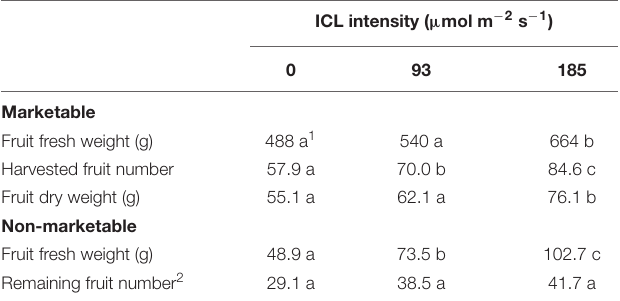
TABLE 6 | Blackberry yield per cane during the autumn production cycle (harvest from 3 October till 12 December as affected by spring production cycle ICL treatments.